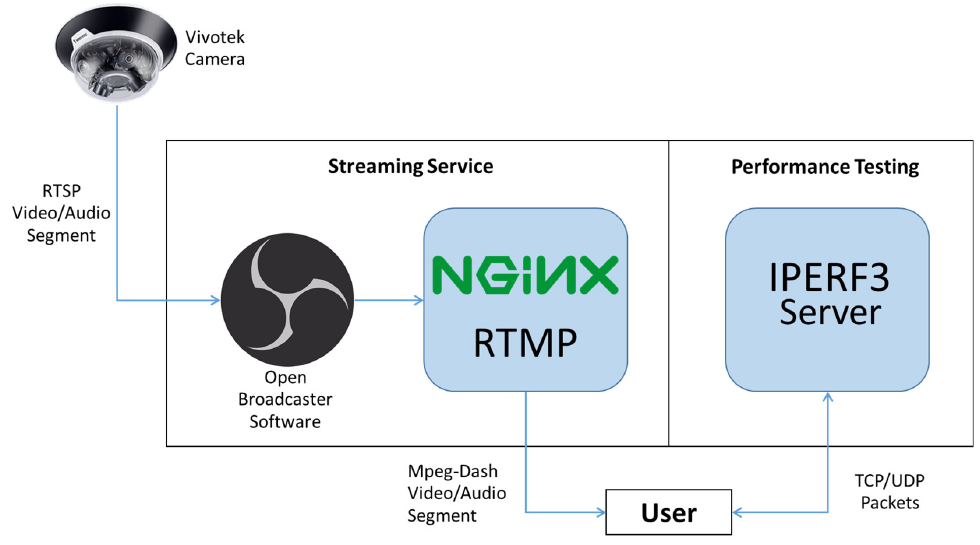
Figure 3. MEC applications—Communication model.